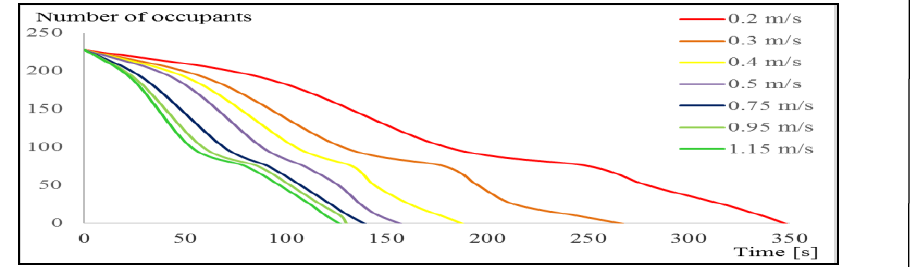
Figure 23 – Simulation results for the slowest times of the seventh case of the second scenario